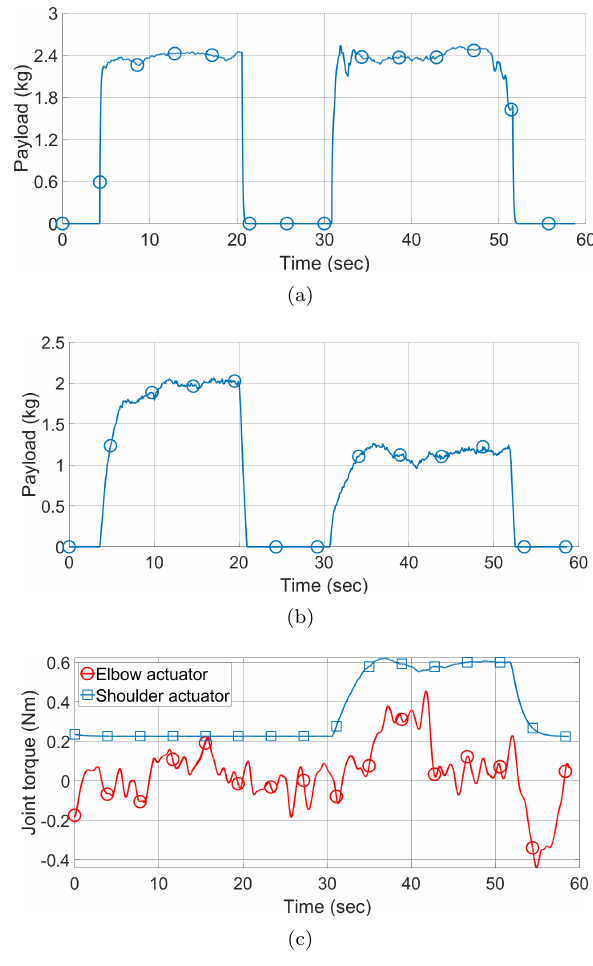
Figure 11: Exoskeleton control results, (a) estimated payload without exoskeleton, (b) estimated payload with exoskeleton and (c) torques provided by exoskeleton at each joint, first in transparent mode (3-21 s) and then in assistive mode (31-52